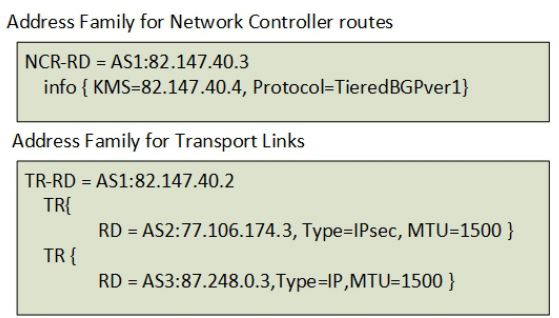
Figure 17. BGP announcements Tier